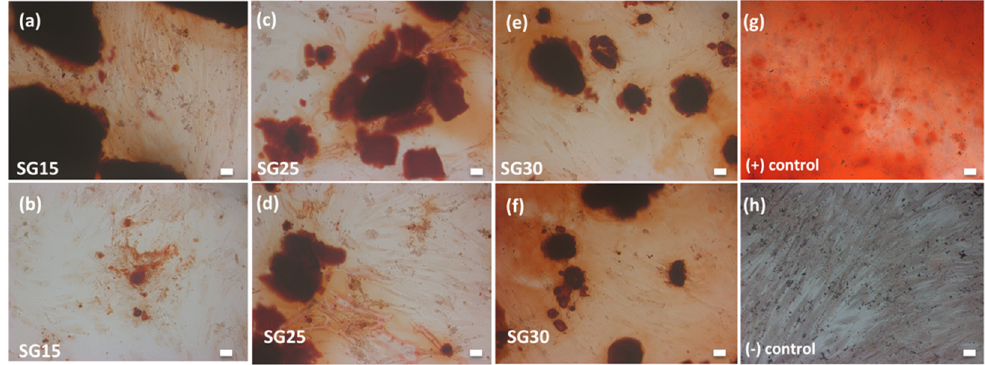
Figure 11. Percentage of FAs according to size in HOB ® cells grown on the described SG15, SG25 and SG30 aerogels after one week of culture. One-way analysis of variance. Statistical significance was defined as p < 0.05.